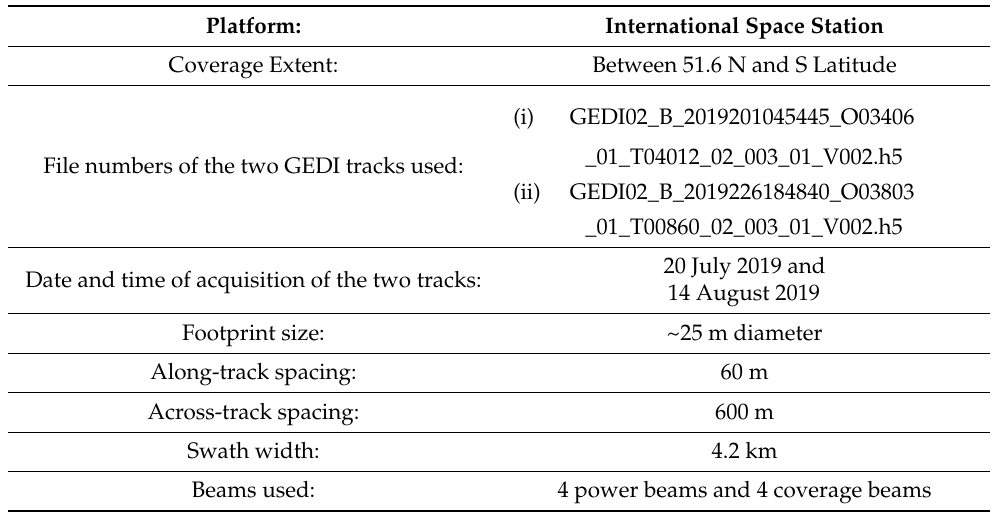
Table 1. Details of the GEDI dataset used in the